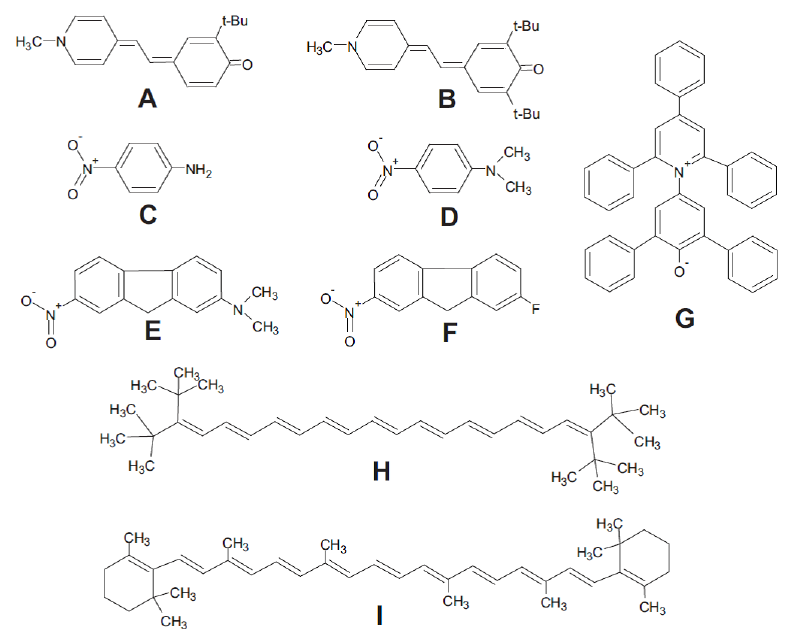
Figure 4. Typical examples of the probes that are employed for the determination of